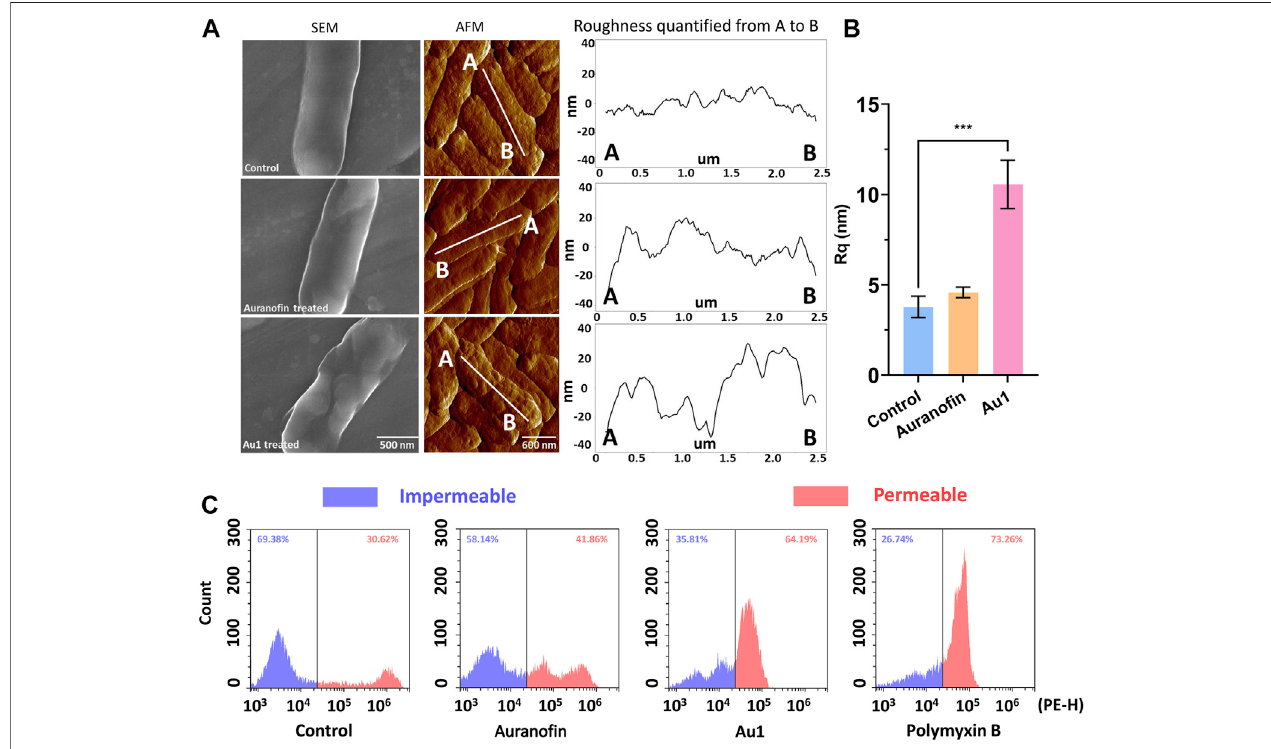
FIGURE 3 | (A) FE-SEM and AFM analysis of the morphology of P. aeruginosa after incubation with Au1 or aurano fi n. (B) Quanti fi cation of the root-mean-square roughness (R q ) of the bacterial surface. All experiments are performed in triplicated and data are presented as mean ± sd. *** means p < 0.001. (C) Flow cytometry analysis of the bacterial membrane permeability after incubation with aurano fi n, Au1 and polymyxin B. Blue colour represents the counted cell with impermeable membrane, and red colour represents the cell with permeable